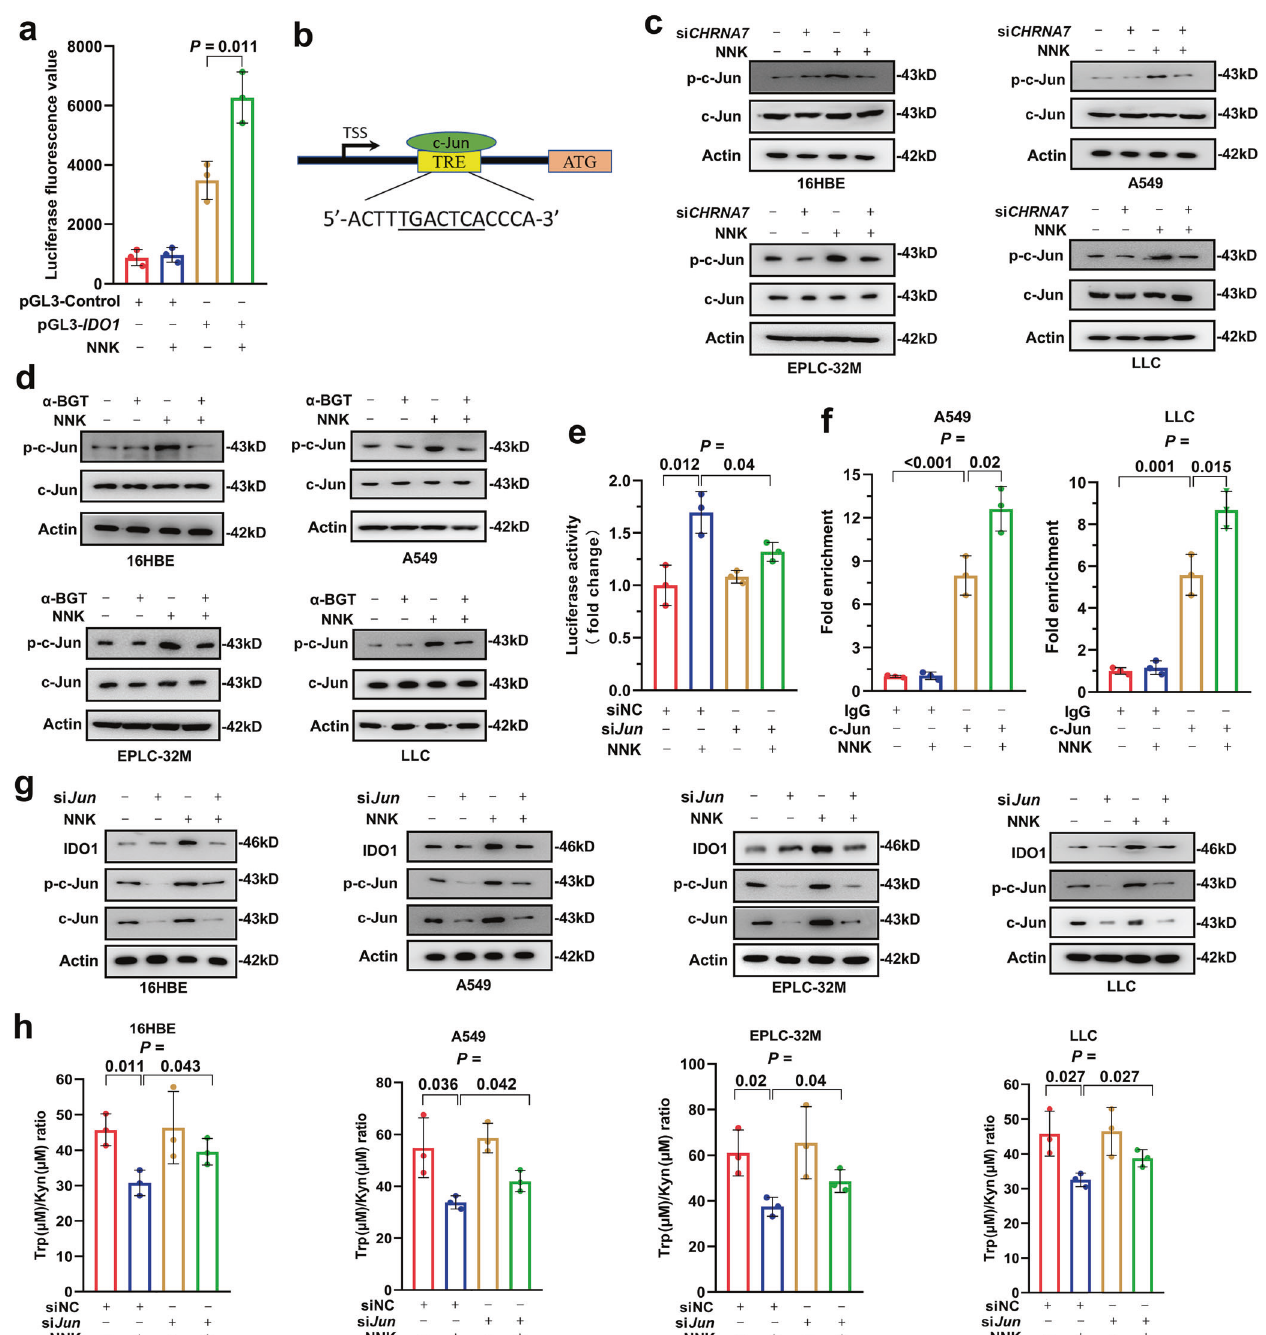
Fig. 5 NNK upregulates IDO1 expression and promotes Trp metabolism in an α 7nAChR/c-Jun-dependent manner. a Luciferase activity driven by the IDO1 promoter in A549 cells treated with 25 μ M NNK for 48 h. b c-Jun binding site in the IDO1 promoter. TSS, transcription start site. c , d The cells were transfected with si CHRNA7 ( c ) or pretreated with α -BGT ( d ) and then treated with 25 μ M NNK for 72 h. The cells were lysed for western blotting using the indicated antibodies. e A549 cells expressing pGL- IDO1 promoter-luciferase were transfected with si- c-Jun , treated with 25 μ M NNK for 72 h, and lysed for analysis of luciferase activity. f A549 and LLC cells were treated with or without NNK and lysed, chromatin immunoprecipitation assays were performed using IgG or an anti-c-Jun antibody, and the precipitated DNA was used to detect the expression of IDO1 by qRT-PCR. g The cells were transfected with si c-Jun , treated with 25 μ M NNK for 72 h, lysed and subjected to western blotting using indicated antibodies. h The cells were transfected with si c-Jun and treated with 25 μ M NNK for 72 h, the concentrations of Trp and Kyn in the supernatants were measured, and the Trp/Kyn ratio was calculated. P values, Student ’ s t test. Error bars, sd inhibits oxidative phosphorylation and induces glycolysis and the can trigger metabolic reprogramming. For example, proteomic generation of reactive oxygen species. 41 However, tobacco smoke- analysis of lung epithelial cells exposed to cigarette smoke shows abnormal oxidative phosphorylation and increase in enzymes for related metabolic abnormalities in lung cancer remain to be the tricarboxylic acid cycle. 26 In macrophages, CSE exposure revealed. Here, we showed that tobacco smoke could enhance Trp